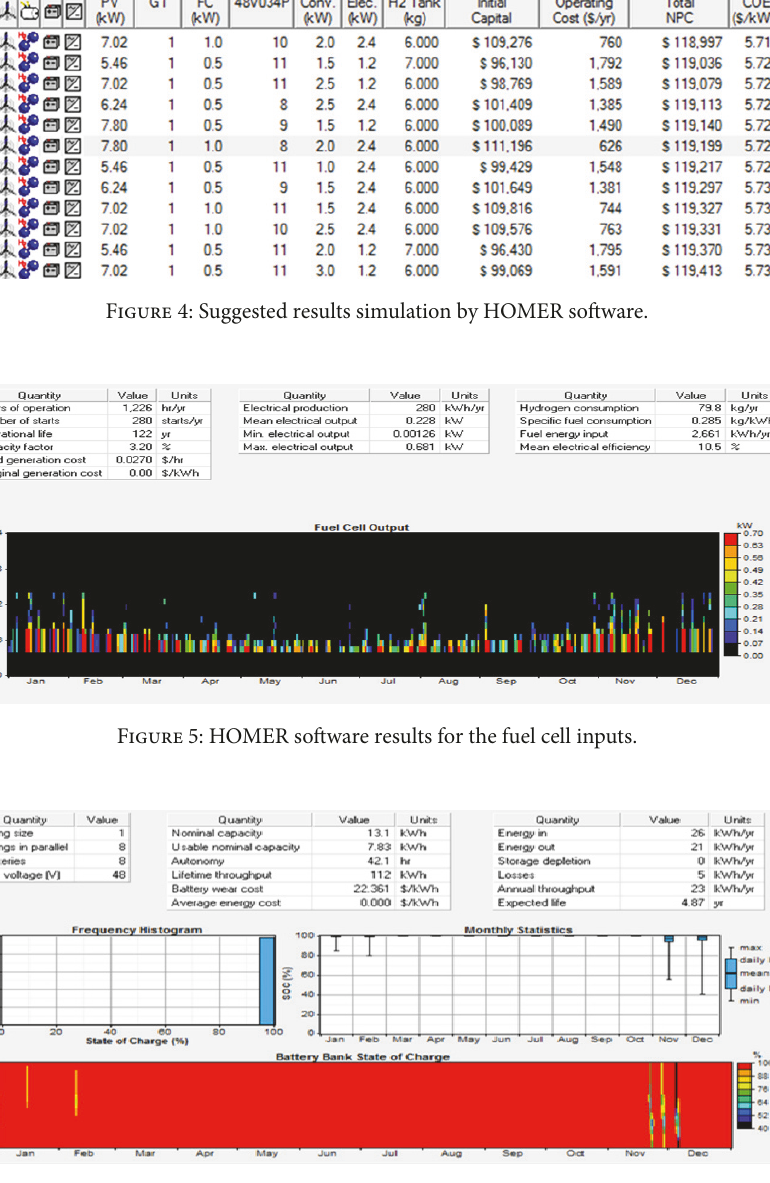
Figure 6: HOMER software results for the